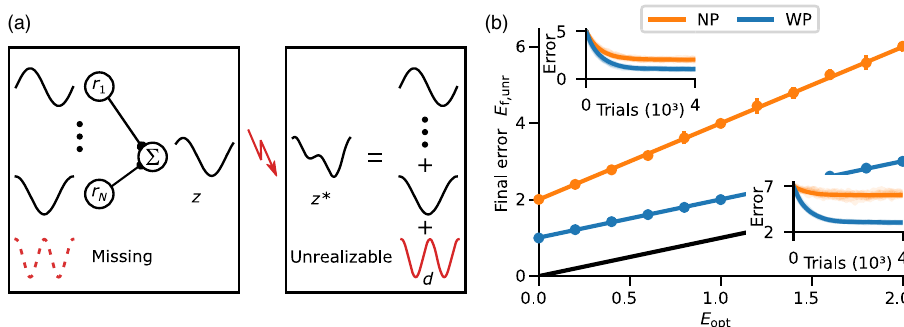
FIG. 3. Unrealizable target components harm NP learning. (a) General targets may contain a component that is perpendicular to any inputand,thus,unrealizable(red).(b)Finalerrorafterconvergenceasafunctionoftheerror E that necessarilyremains,since thetargetis opt unrealizable. The final error of WP (blue) is shifted only by E ; that of NP (orange) increases twice as fast, by approximately 2 E . Data opt opt points: mean and standard deviation (averaged over ten simulated runs) of the final error. Curves: theoretical predictions. Black: E . opt 0 (left) and E 2 (right). Parameters: M ¼ 10 , N; T ¼ 100 , N 50 , and σ 0 . 04 Insets: error dynamics for E opt ¼ opt ¼ eff ¼ eff ¼